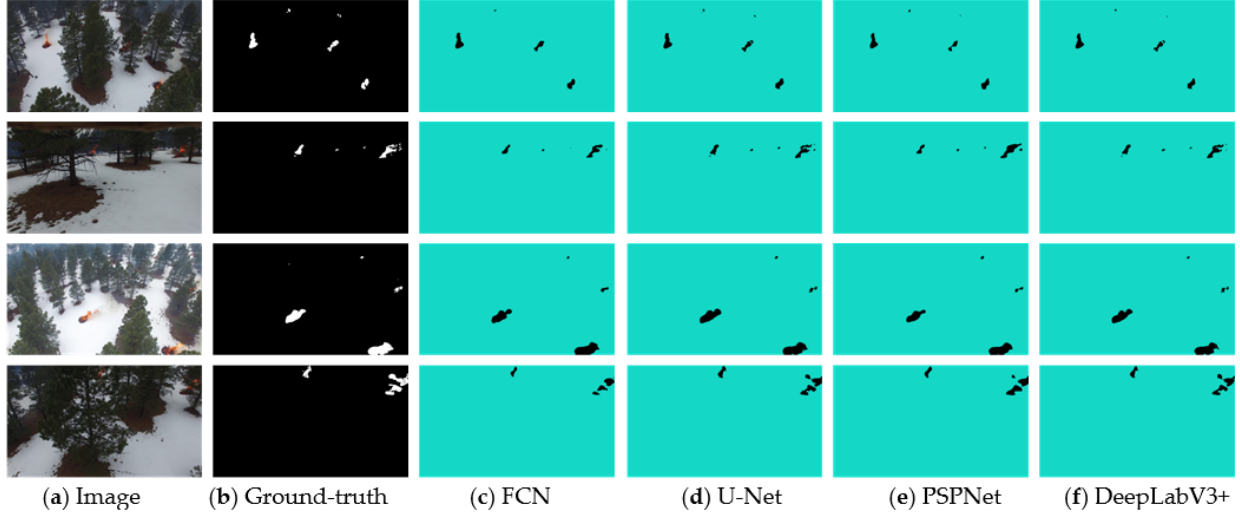
Figure 8. Results of forest fire image segmentation (VGG16).